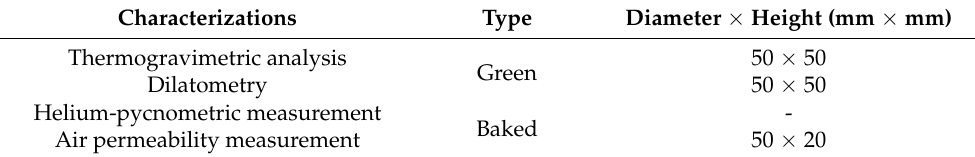
Figure 2. Heating program [28].